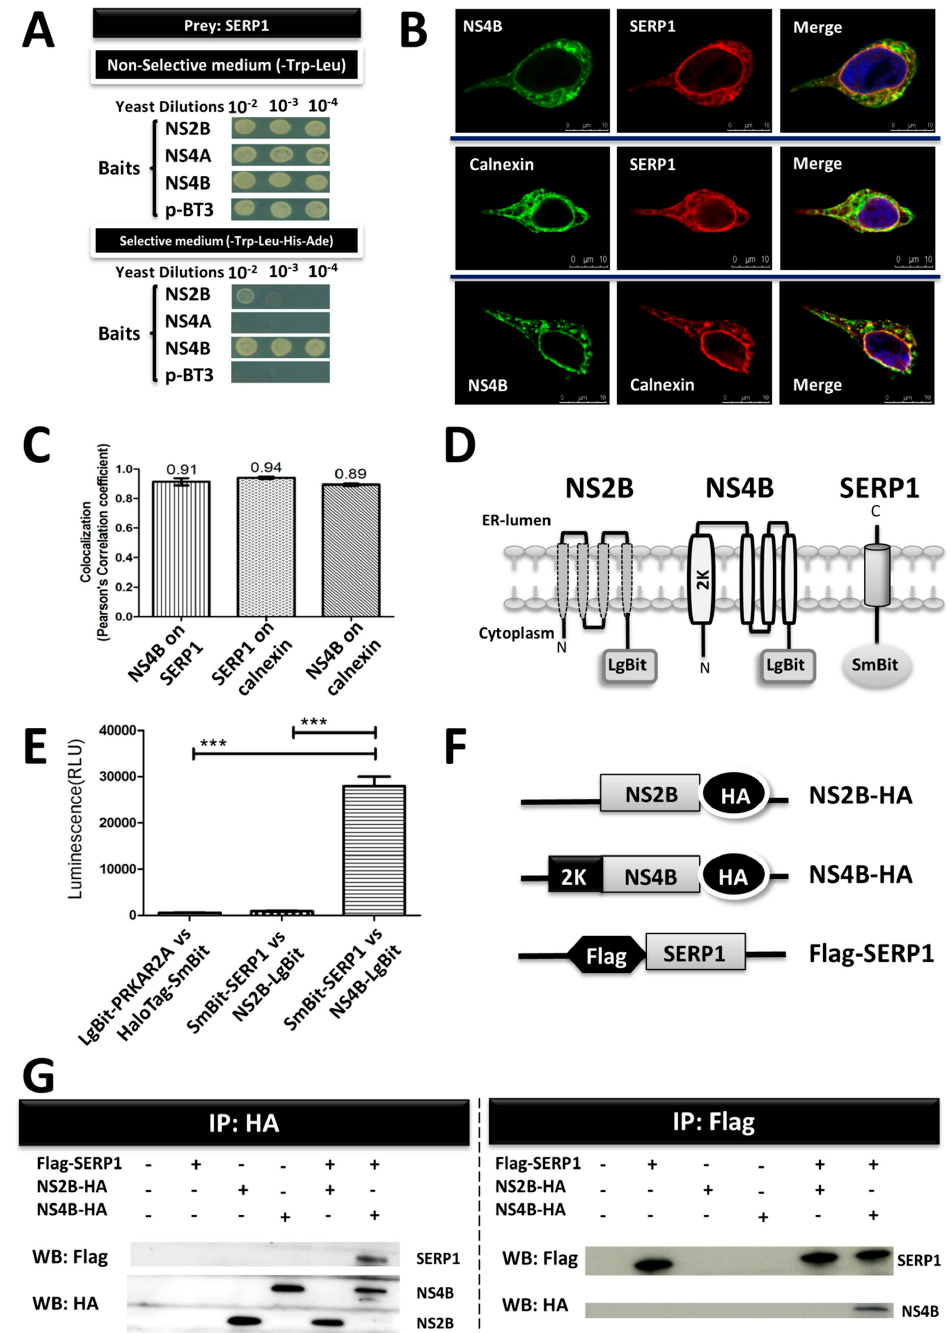
Figure 1. Protein–protein interactions between stress-associated endoplasmic reticulum protein 1 (SERP1) and nonstructural protein (NS)4B. ( A ) NS4B interacts with SERP1, as shown in a membrane-base split ubiquitin yeast-two-hybrid assay. Yeast was co-transformed with the baits p-BT3 NS2B, p-